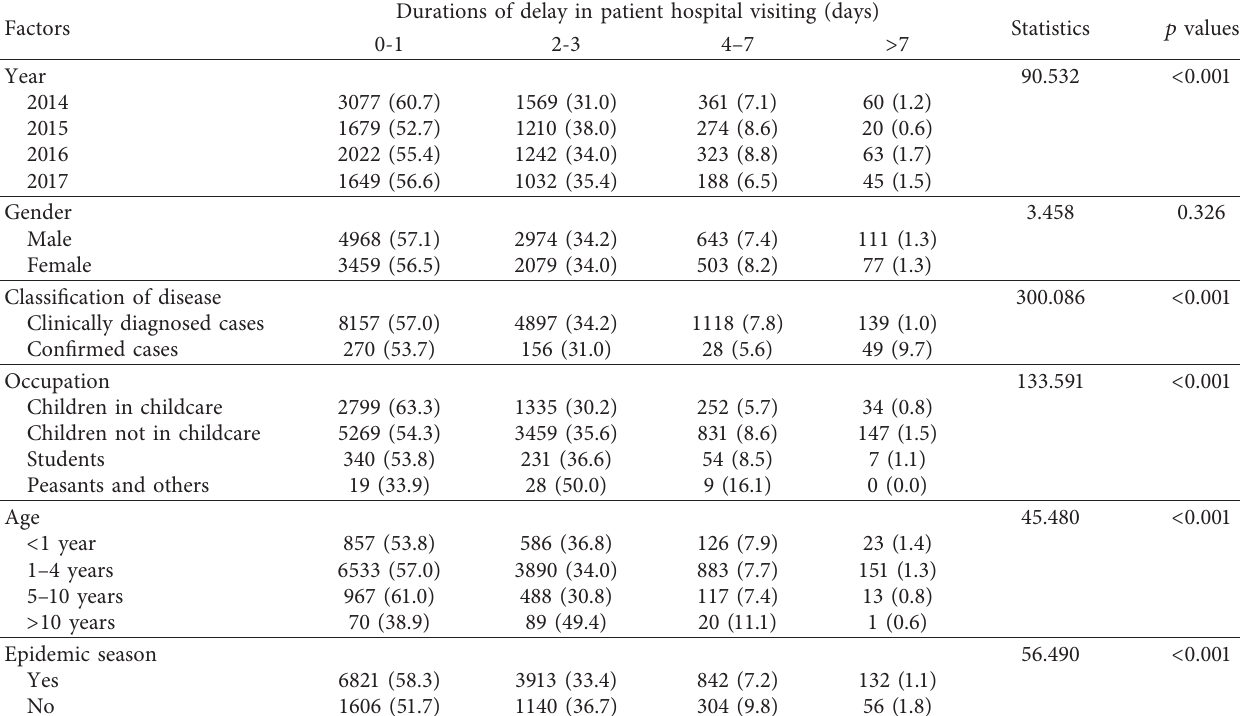
Table 2: Comparisons of durations of delay in patient hospital visiting for hand-foot-and-mouth disease across different factors.